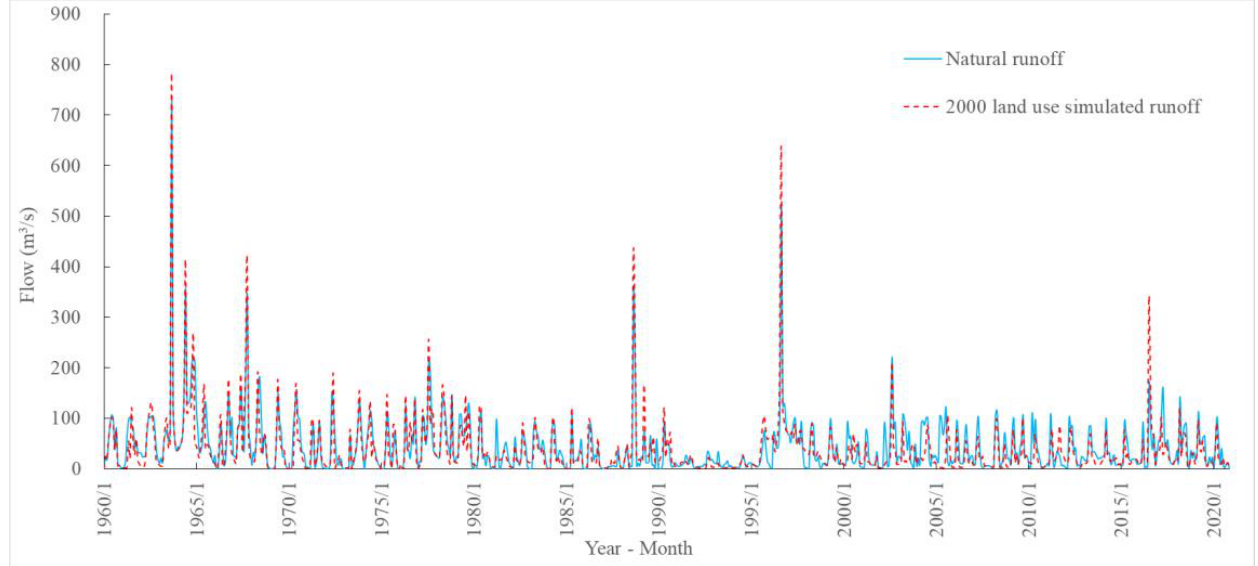
Figure 5. Comparison of simulated and natural runoff under the land-use scenario of 2000 at the Huangbizhuang Station.